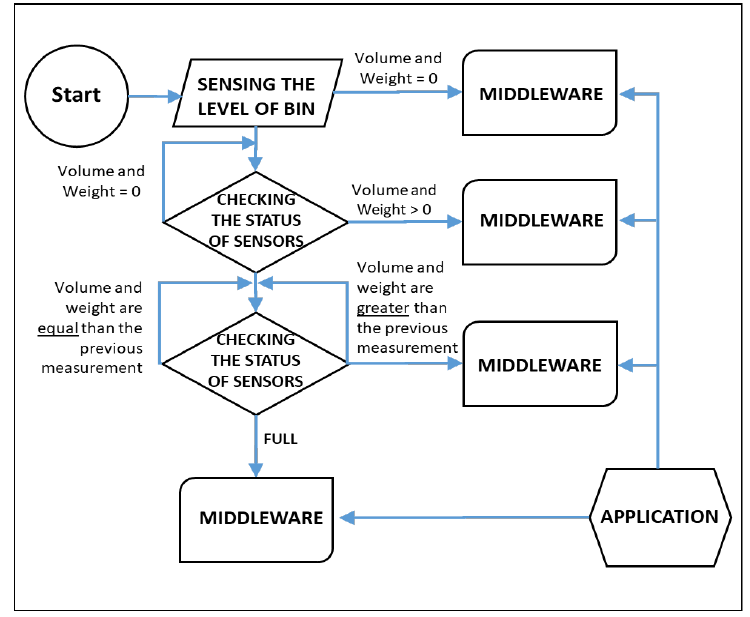
Figure 4. My Waste Bin Flowchart.